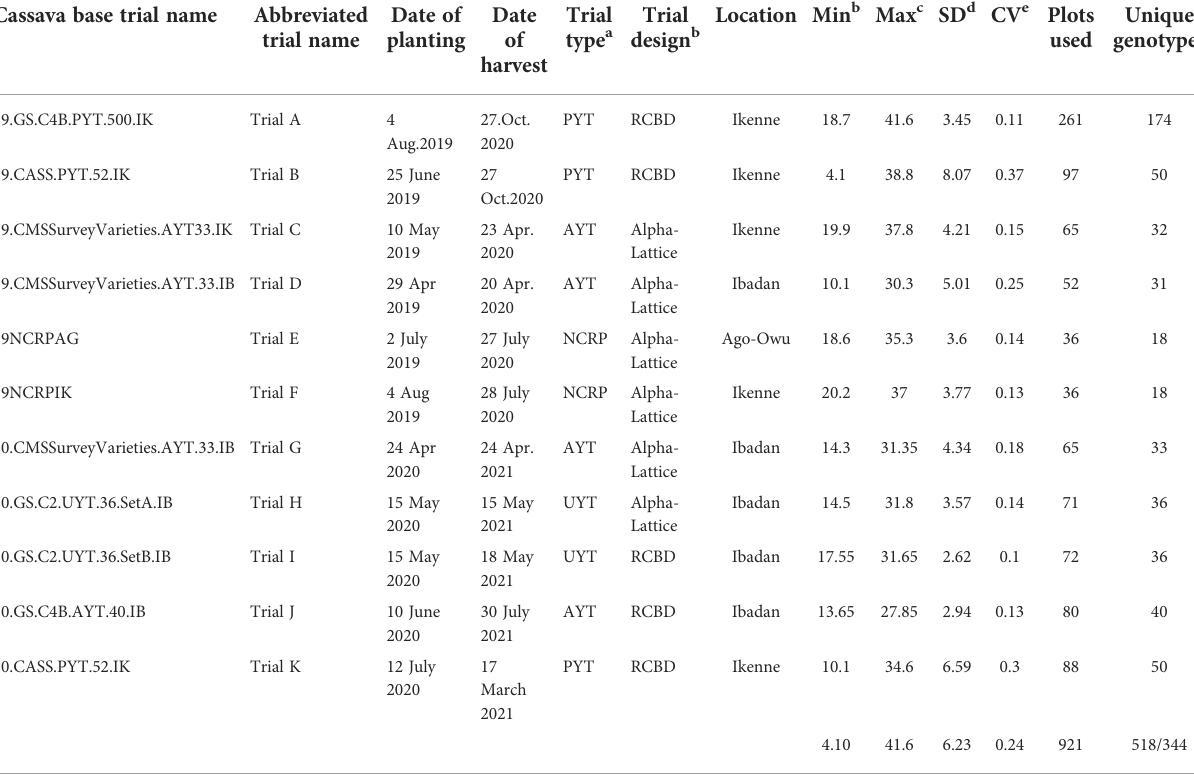
TABLE 1 Cassava breeding fi eld trial metadata and summary statistics for root starch